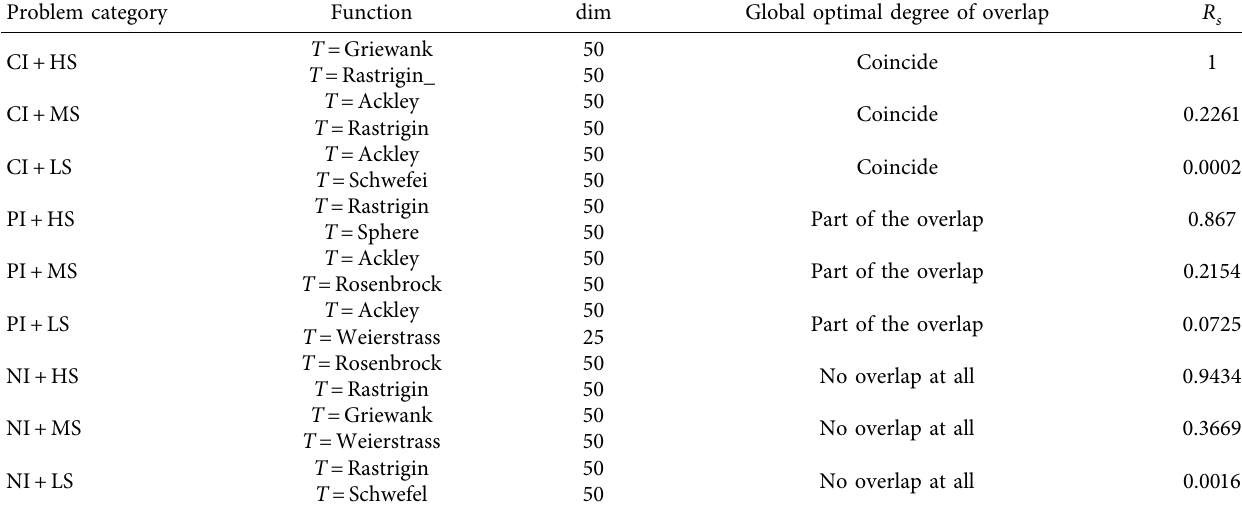
Table 4: Single-objective multitask benchmarking problems.